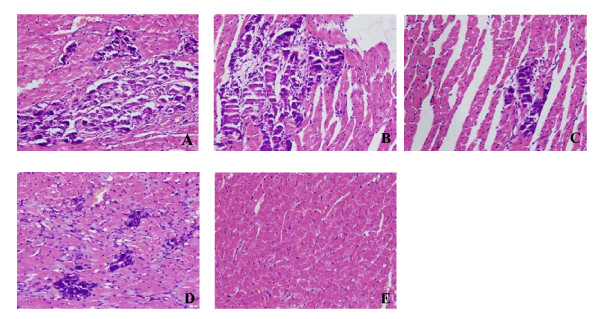
Evaluation of the severity of myocarditis. (a-e) are representative of histopathologic images in heart tissue from saline, B, BIFN and interferon (IFN) groups respectively (hemotoxylin and eosin (H&E) staining, original magnification × 200). Ten mice per group were analyzed in this study.